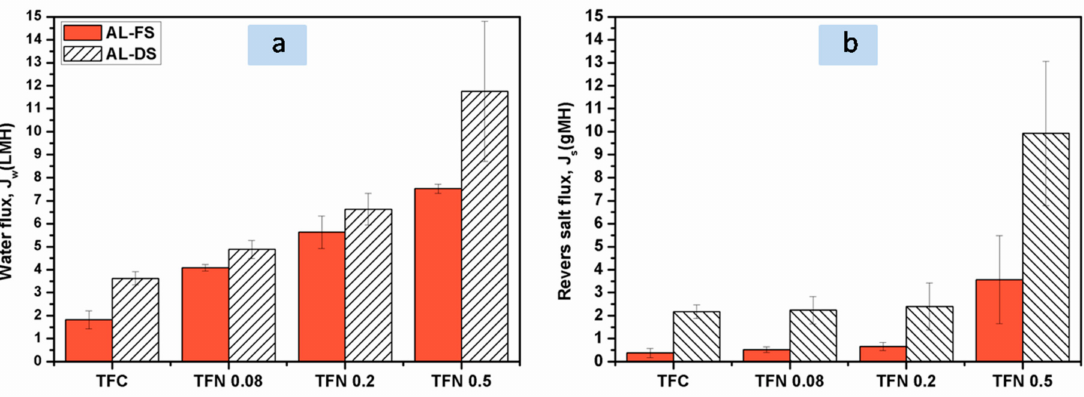
Figure 5. Forward osmosis (FO) performance tests: ( a ) water fluxes, and ( b ) reverse salt fluxes across the FO membranes. Experimental conditions: 25 ◦ C, 1 M NaCl as the draw solution, DI water as the feed solution, and cross-flow velocities of 40 L / h on both sides of the membranes. Data were obtained from at least three tests on independent